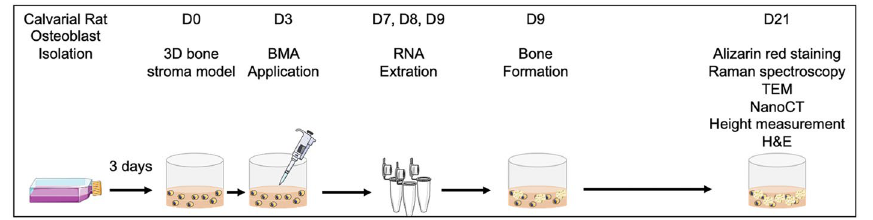
Figure 2. Time points for each bone nodule characterisation method. Diagram was created using Servier Medical